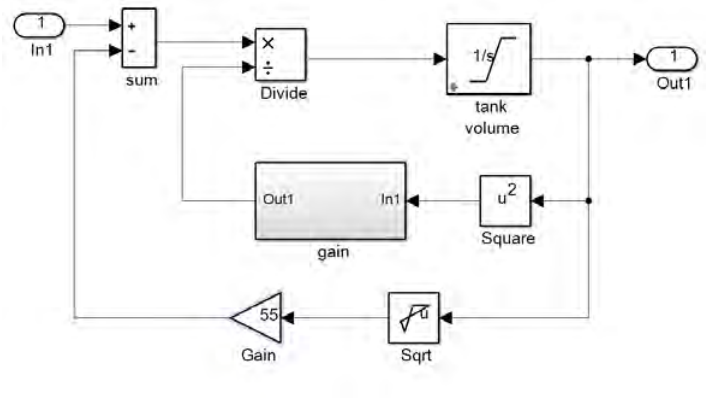
Figure 8. (b) Subsystem tank